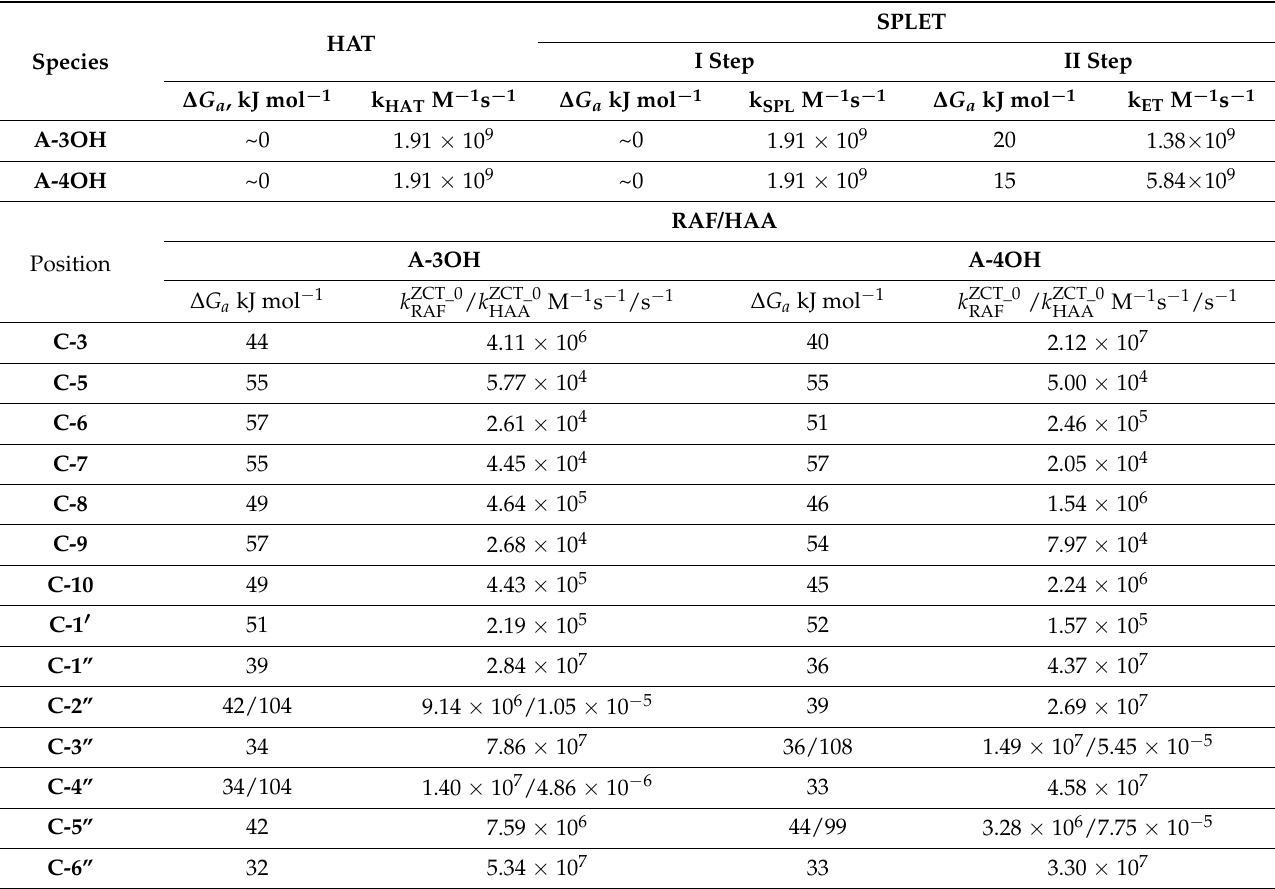
Table 2. Activation energies ( ∆ G a ) reaction and rate constants for the various mechanistic pathways estimated by Eckart’s method ( k ZCT_0